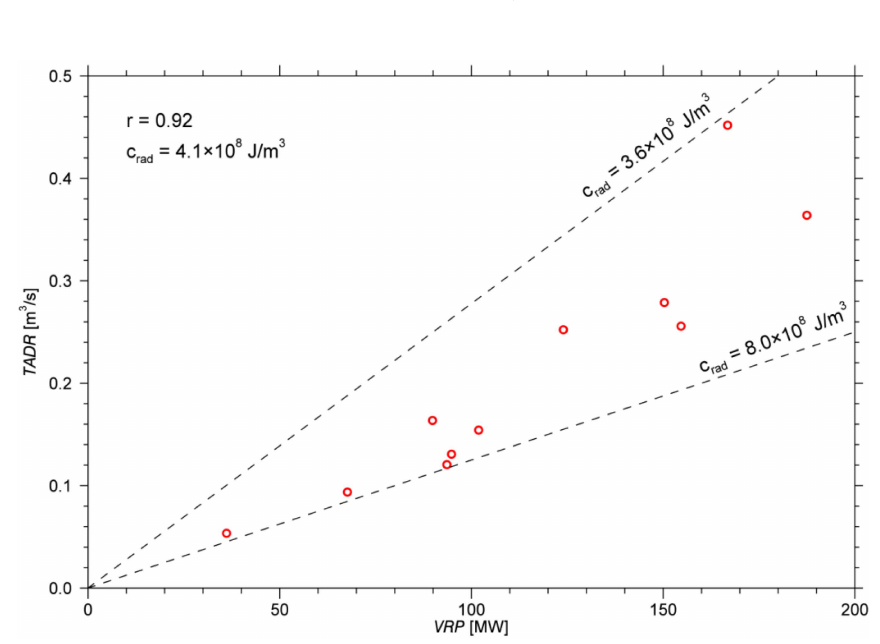
Figure 8. TET-1 data shows that TADR is well correlated to VRP , allowing a linear fit of the radiant density also for